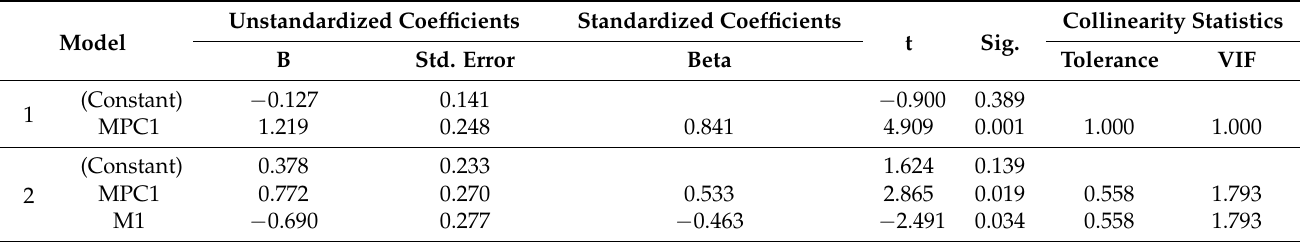
Table 2. Multivariate linear regression model variable